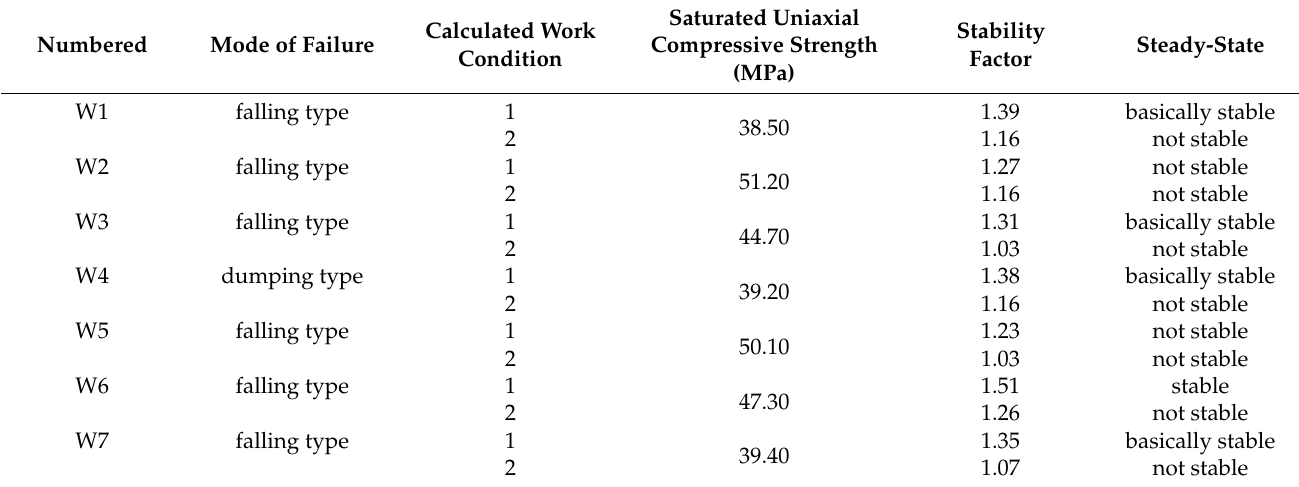
Table 5. Calculation results of the stability of the perilous rock